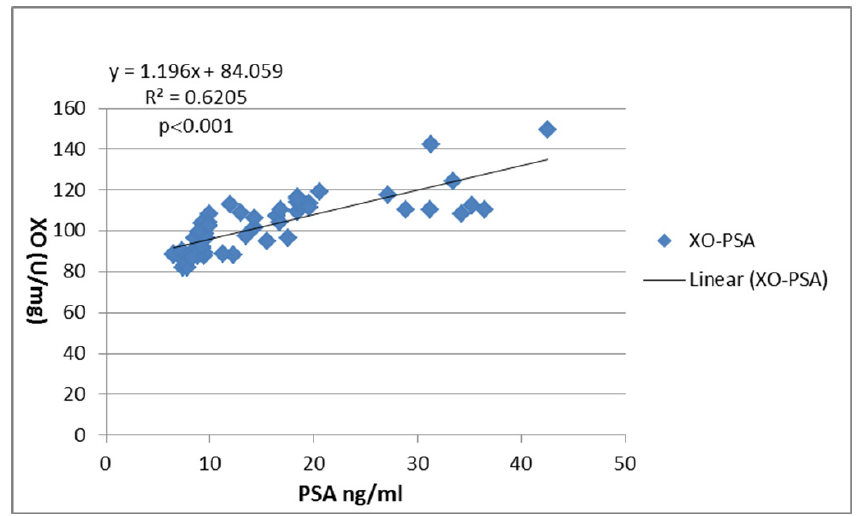
Figure 5. Correlation between XO activity in tumor tissue versus serum prostate-specific antigen (PSA). The correlation was estimated using the Pearson correlation coefficient (r) and illustrated using a scatter plot. p -value < 0.05 is considered significant.